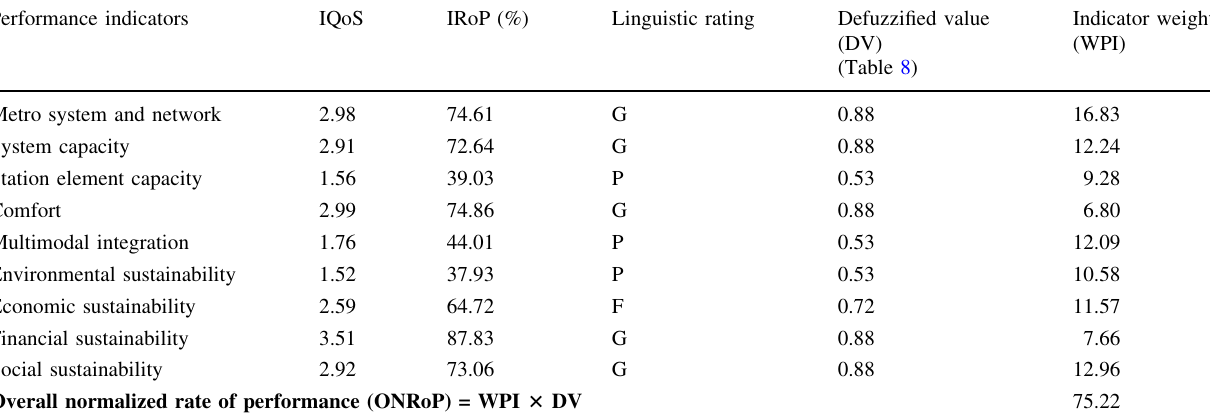
Table 9 Performance ratings after defuzzification Performance